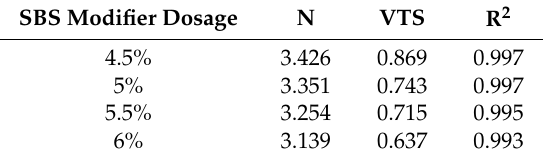
Table 7. Fitting result of viscosity-temperature curve for SBS modified asphalt. 209